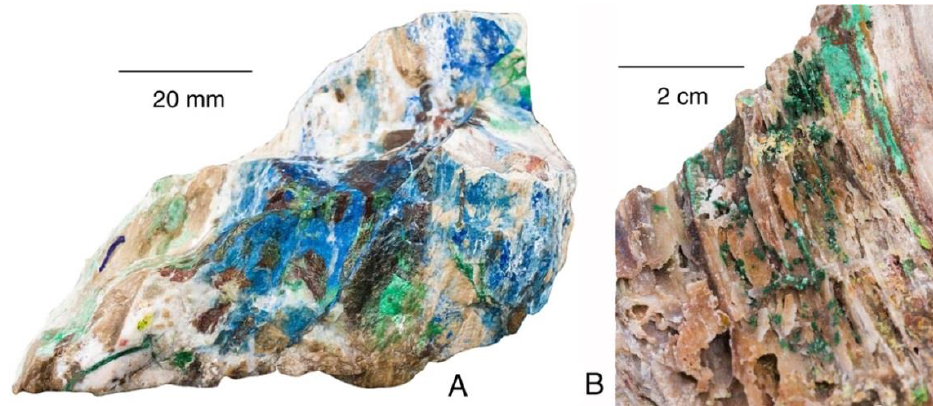
Figure 20. “Colla wood” primarily owes its bright colors to blue azurite ( A ) and green malachite ( B ).